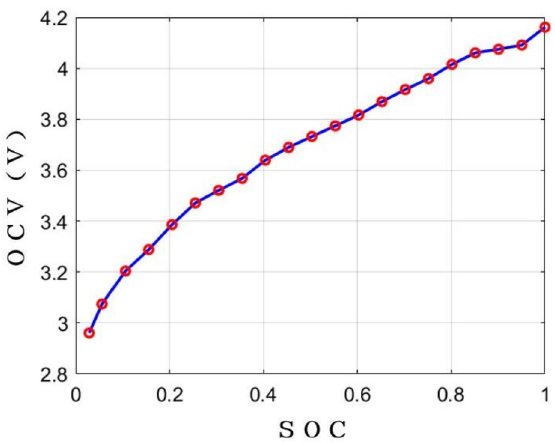
Figure 2. Open circuit voltage (OCV) and state of charge (SOC) (SOC-OCV) discharge relation- ship curve.